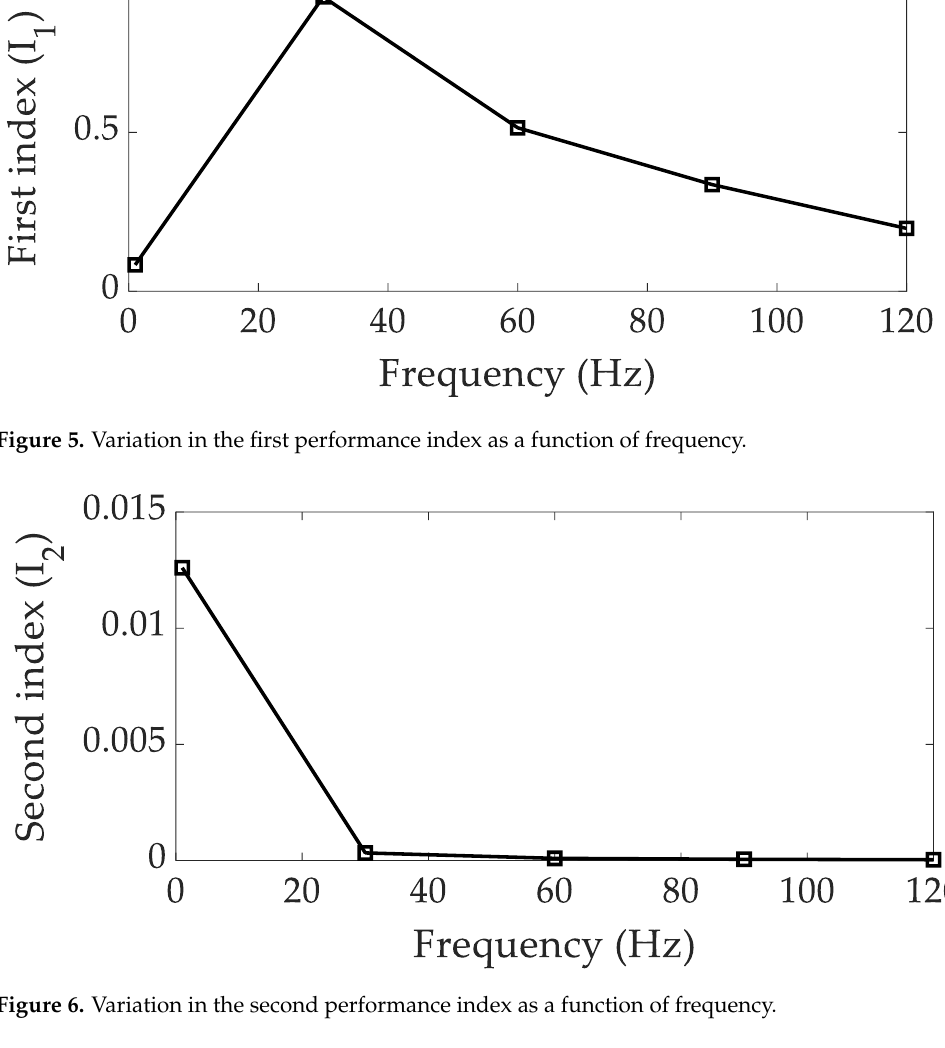
1.6 Table 4. Ratio of the second performance index for four vibration isolator cases.